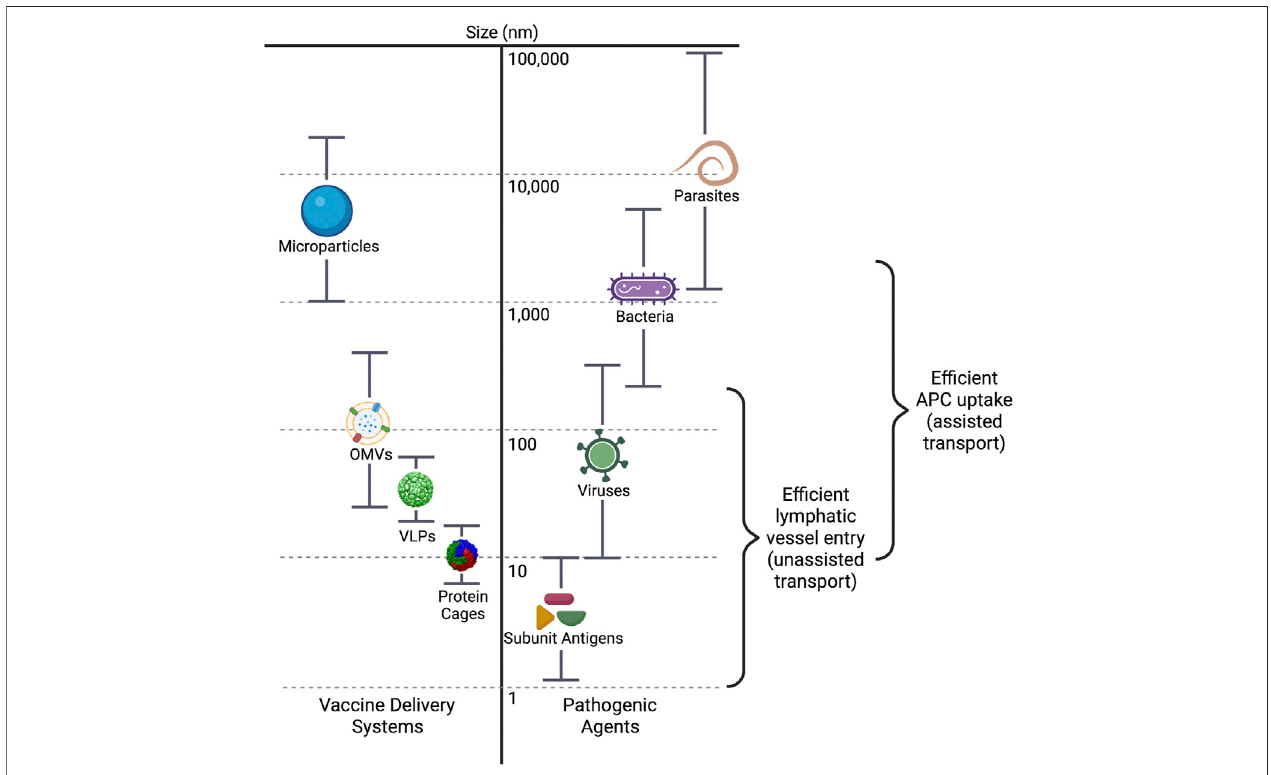
FIGURE 3 | Size ranges of vaccine delivery systems and pathogenic agents. The dimensions of the main particle systems discussed in this review, including microparticle/hybrid structures, are compared to those of pathogenic agents in nanometers. The size ranges for ef fi cient entry into the lymphatic vessels and ef fi cient uptake by antigen presenting cells (APCs) are also indicated. VLPs, virus-like particles; OMVs, outer membrane